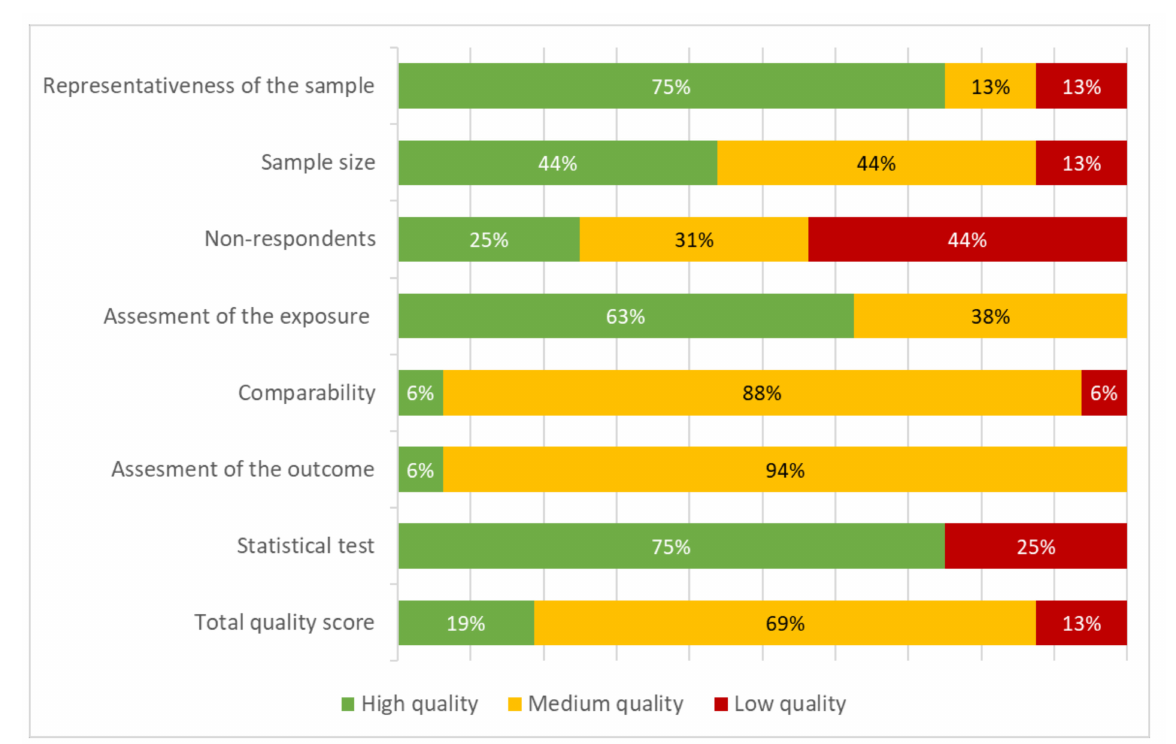
Figure 2. NOQAS quality assessment of included publications (N =